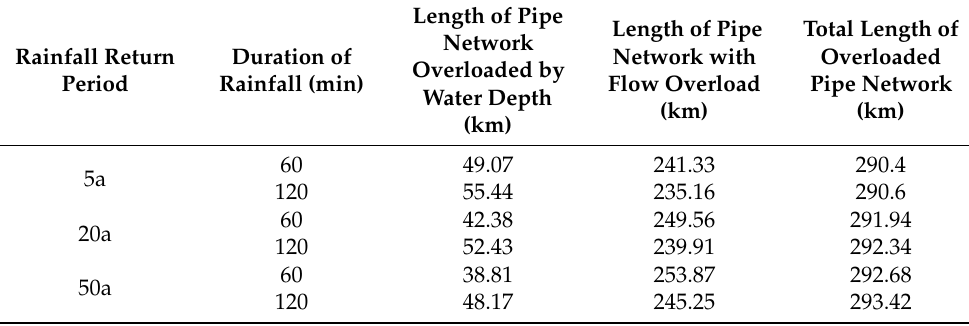
Table 5. Statistics for overloading of the pipe network for different